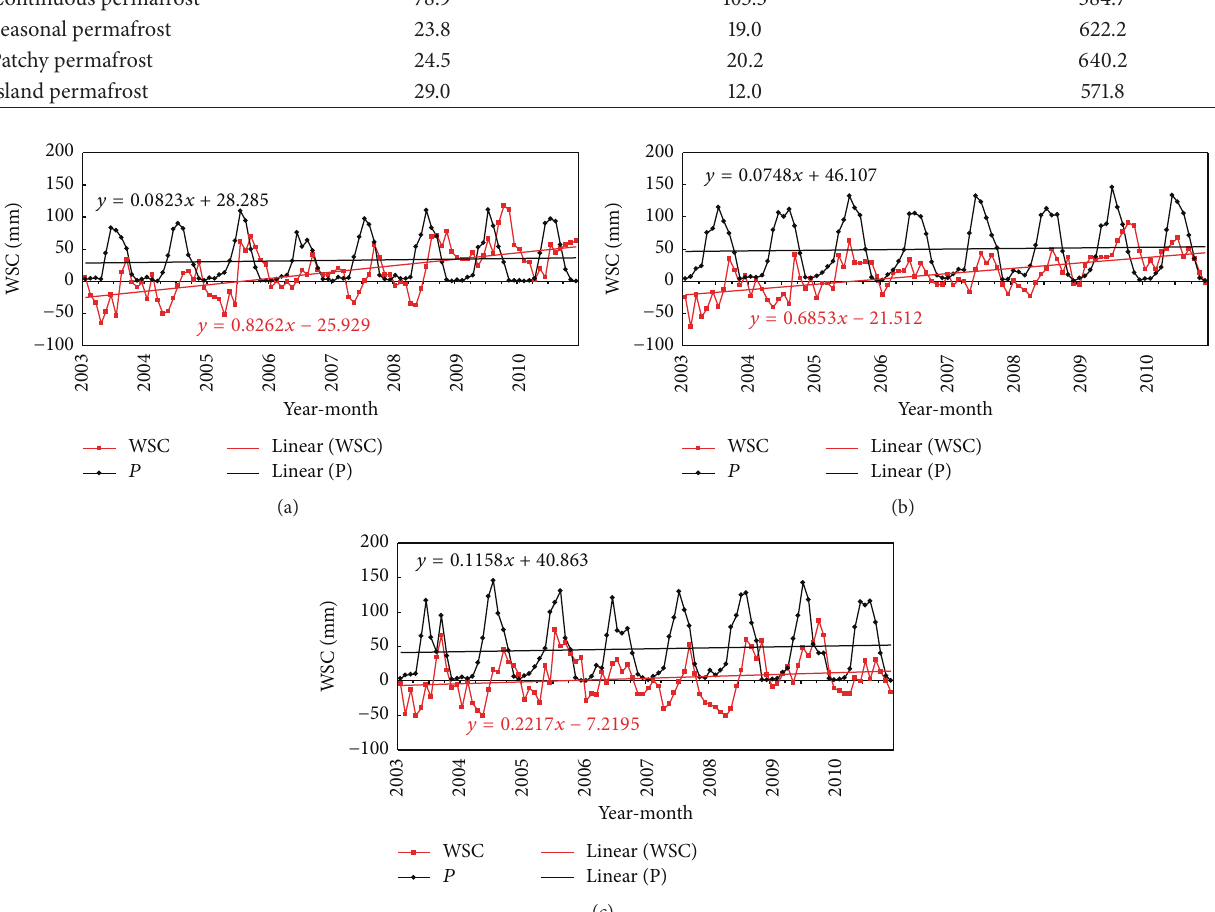
Figure 7: Time series of water storage change (WSC) and precipitation ( 𝑃 ) over the subregions of the Three-River Source Region during 2003–2010: (a) the Yangtze River, (b) the Yellow River, (c) the Lancang River.